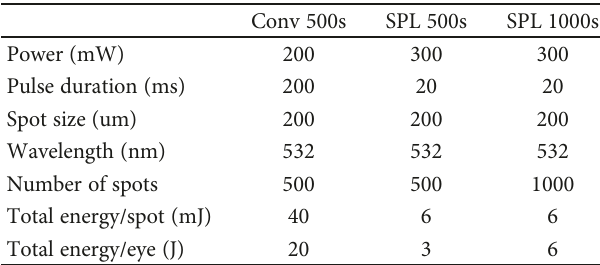
Table 1: Laser parameter